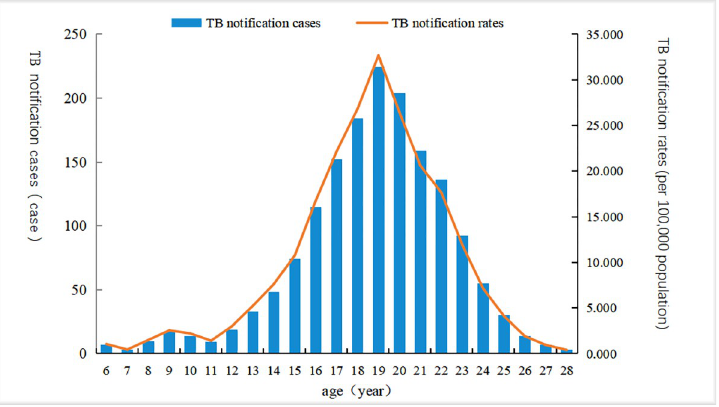
Fig 2. Overall age distribution of reported cases of pulmonary tuberculosis among students in Nanning, from 2012 to 2018.